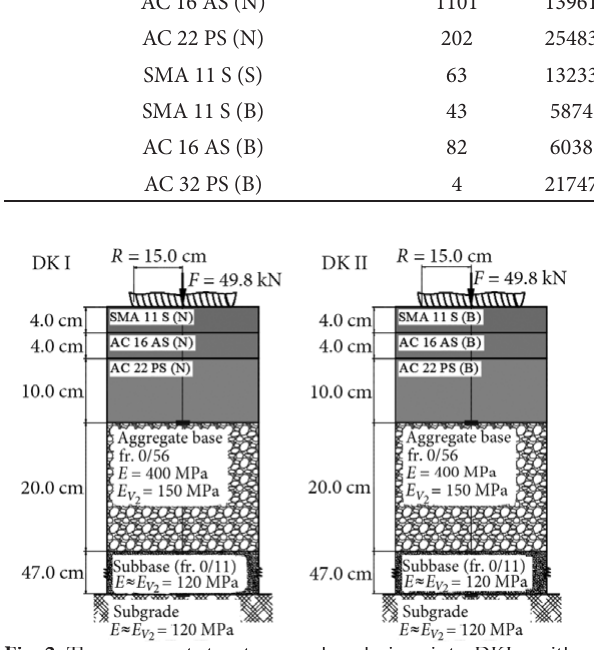
Fig. 2. The pavement structures and analysis points: DKI – with new asphalt mixtures; DKII – with mixtures from eight years old